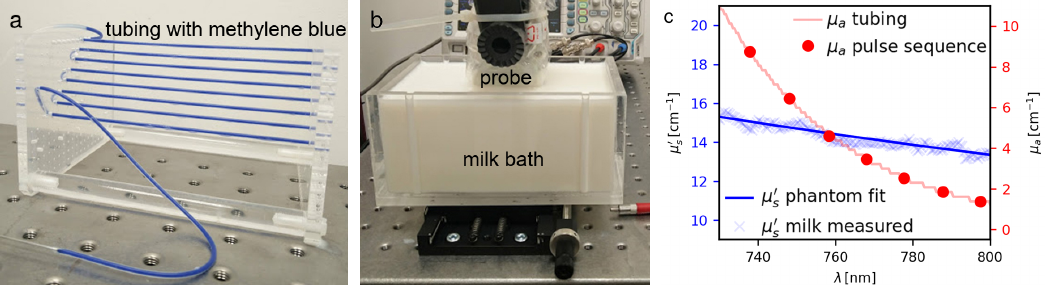
Figure 2. The characterization phantom, consisting of ( a ) an array of silicone tubing filled with diluted methylene blue and placed inside ( b ) a tank filled with diluted milk. ( c ) The methylene blue in the tubing was diluted to yield absorption coefficients as encountered in blood in the near infrared range (the overlaid dots are the wavelengths of the acquisition sequences). The milk was diluted to yield a reduced scattering coefficient consistent with